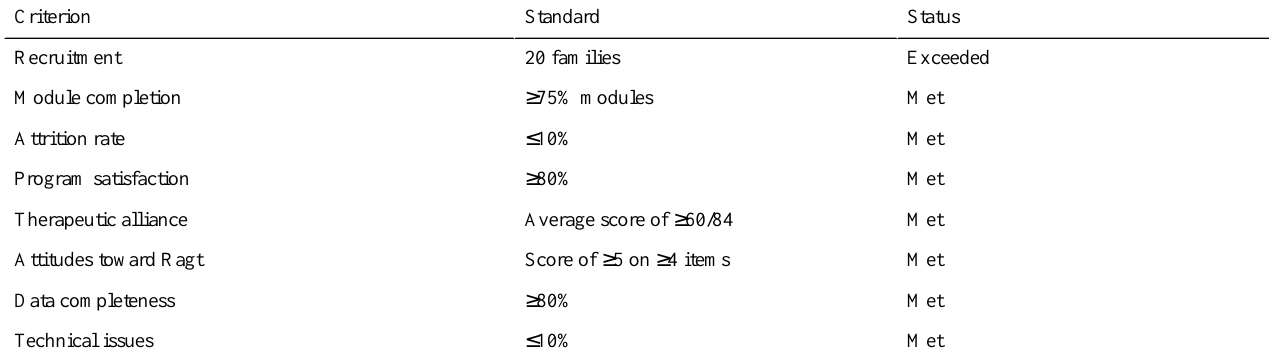
Table 6. Feasibility criteria.